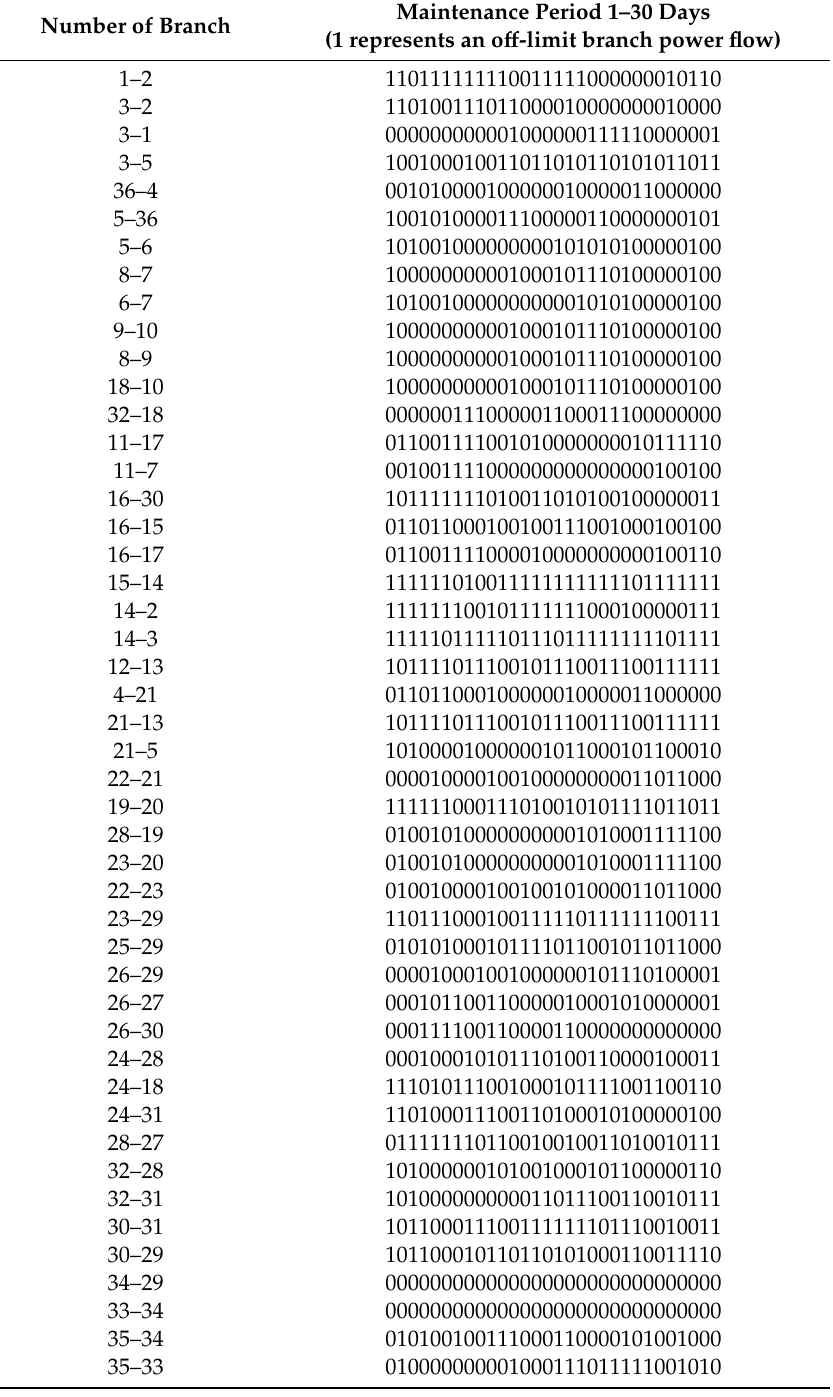
Table A9. Solution D o ff -limit branch power flow in the Hubei electrical